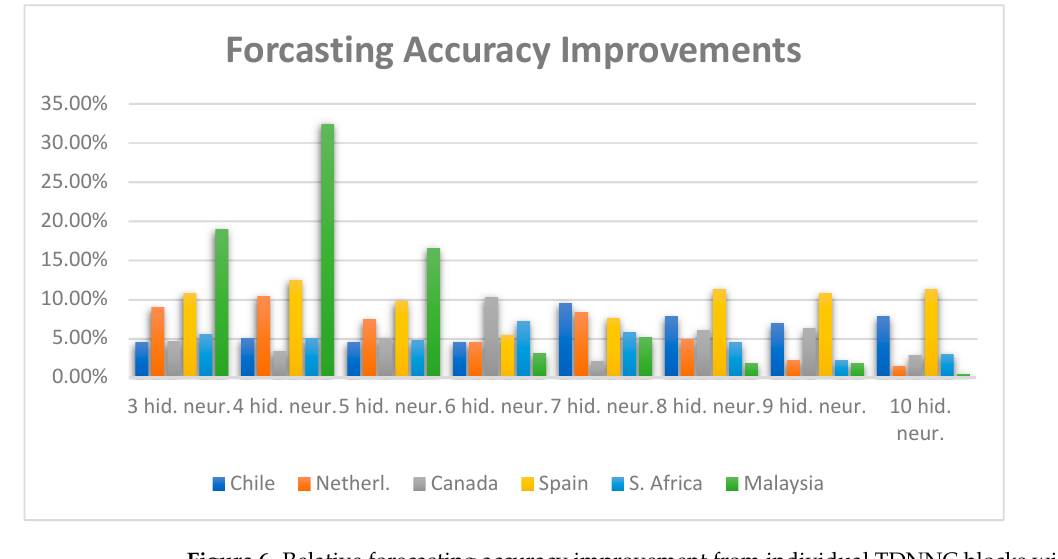
Figure 6. Relative forecasting accuracy improvement from individual TDNNC blocks with the num- ber of neurons in the hidden layer varying from three to ten, to the constructed optimal forecasting system, for six world countries. Table 3. Performance measures (RMSE, MAPE and R 2 ) for the optimal forecasting system, and for the Extreme Learning Machine forecasting methodology for different countries.